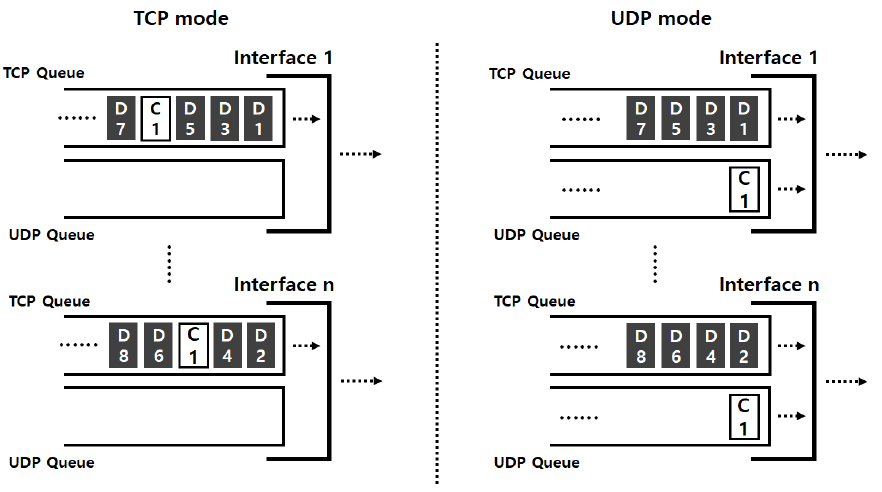
Figure 2. The difference between TCP and UDP modes of MuTran